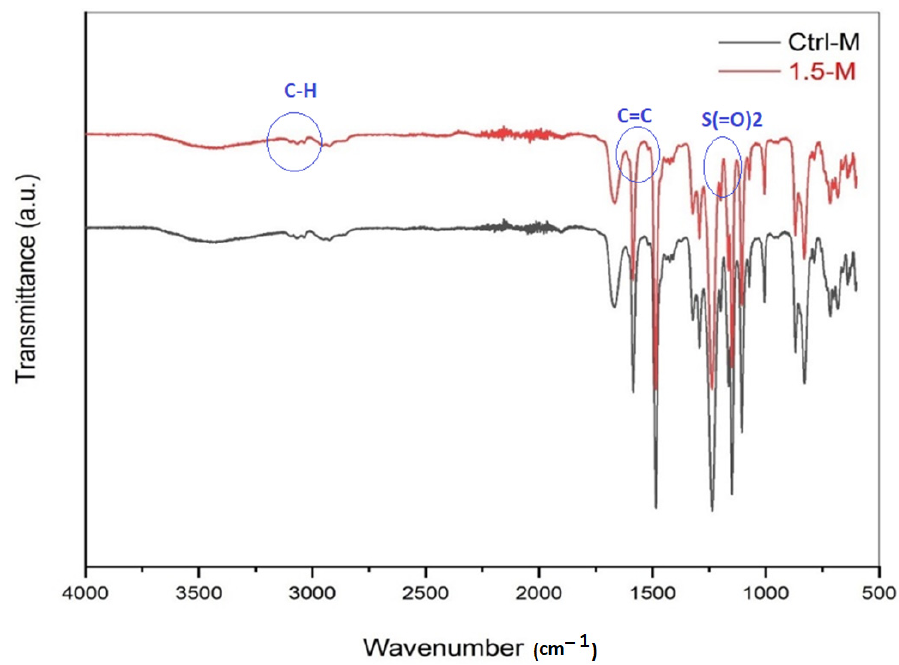
Figure 4. FTIR spectra of control and 1.5 wt.% MXene-modified NF membranes.